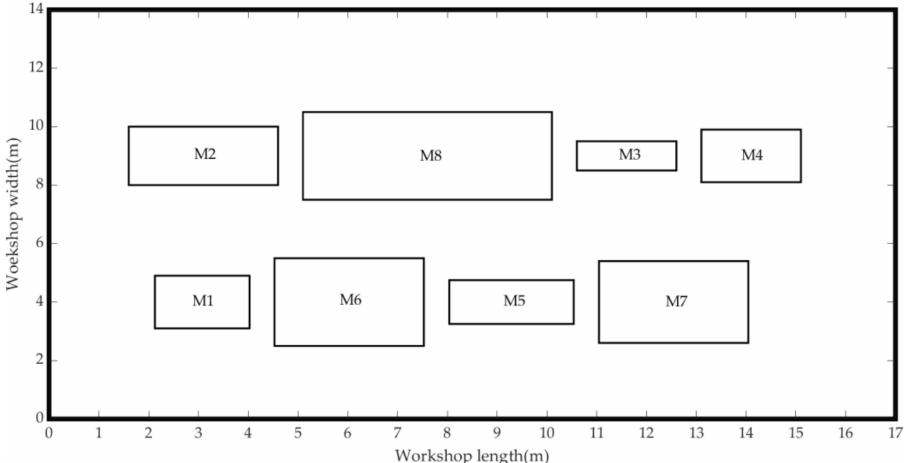
Figure 15. The layout scheme of solution 1.